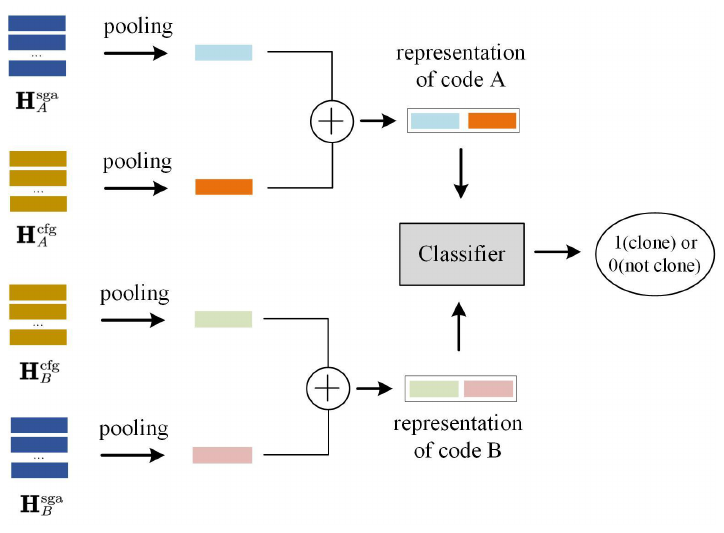
Figure 10. The feature concatenation process in Variant 5.